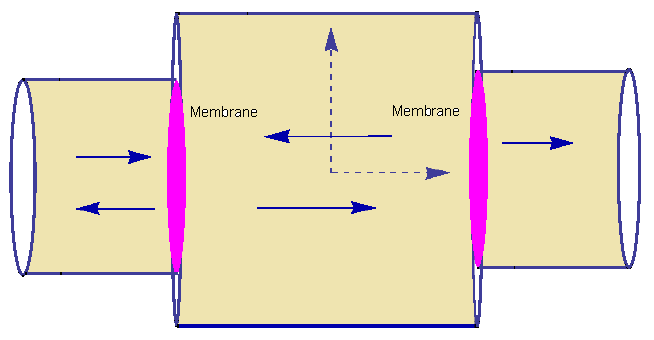
Figure 2. Geometrical